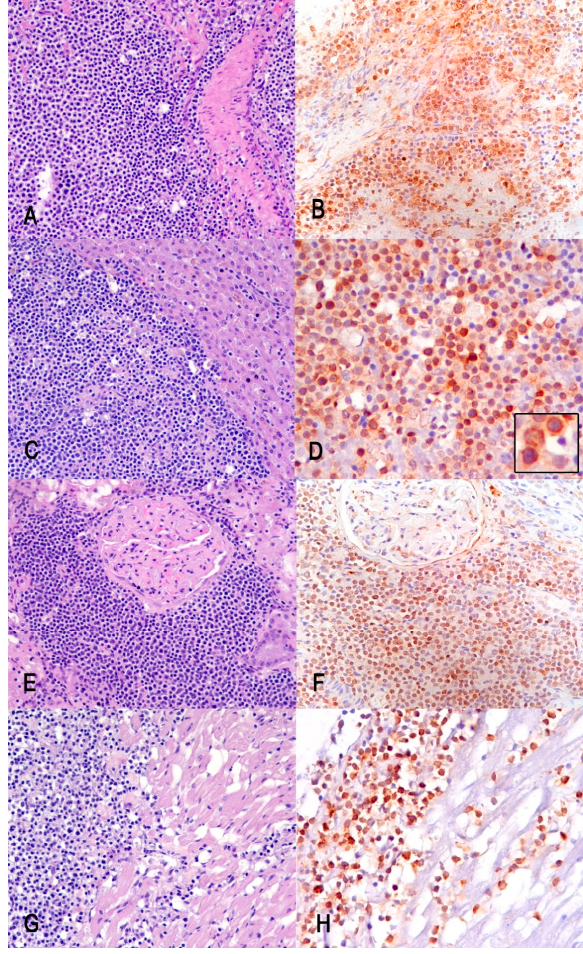
Figure 4. Multiorgan infiltration of neoplastic B cells. Hematoxylin–eosin (HE) and CD79 α -positive immunohistochemistry stain (IHC), respectively, of the spleen ( A , B ), the liver ( C , D ), the kidney ( E , F ), and the heart ( G , H ). Insert in D: details of the membranous CD79 α -positive stain. ( A – C , E – G ) Magnification 200×; ( D , H ) magnification 400×.